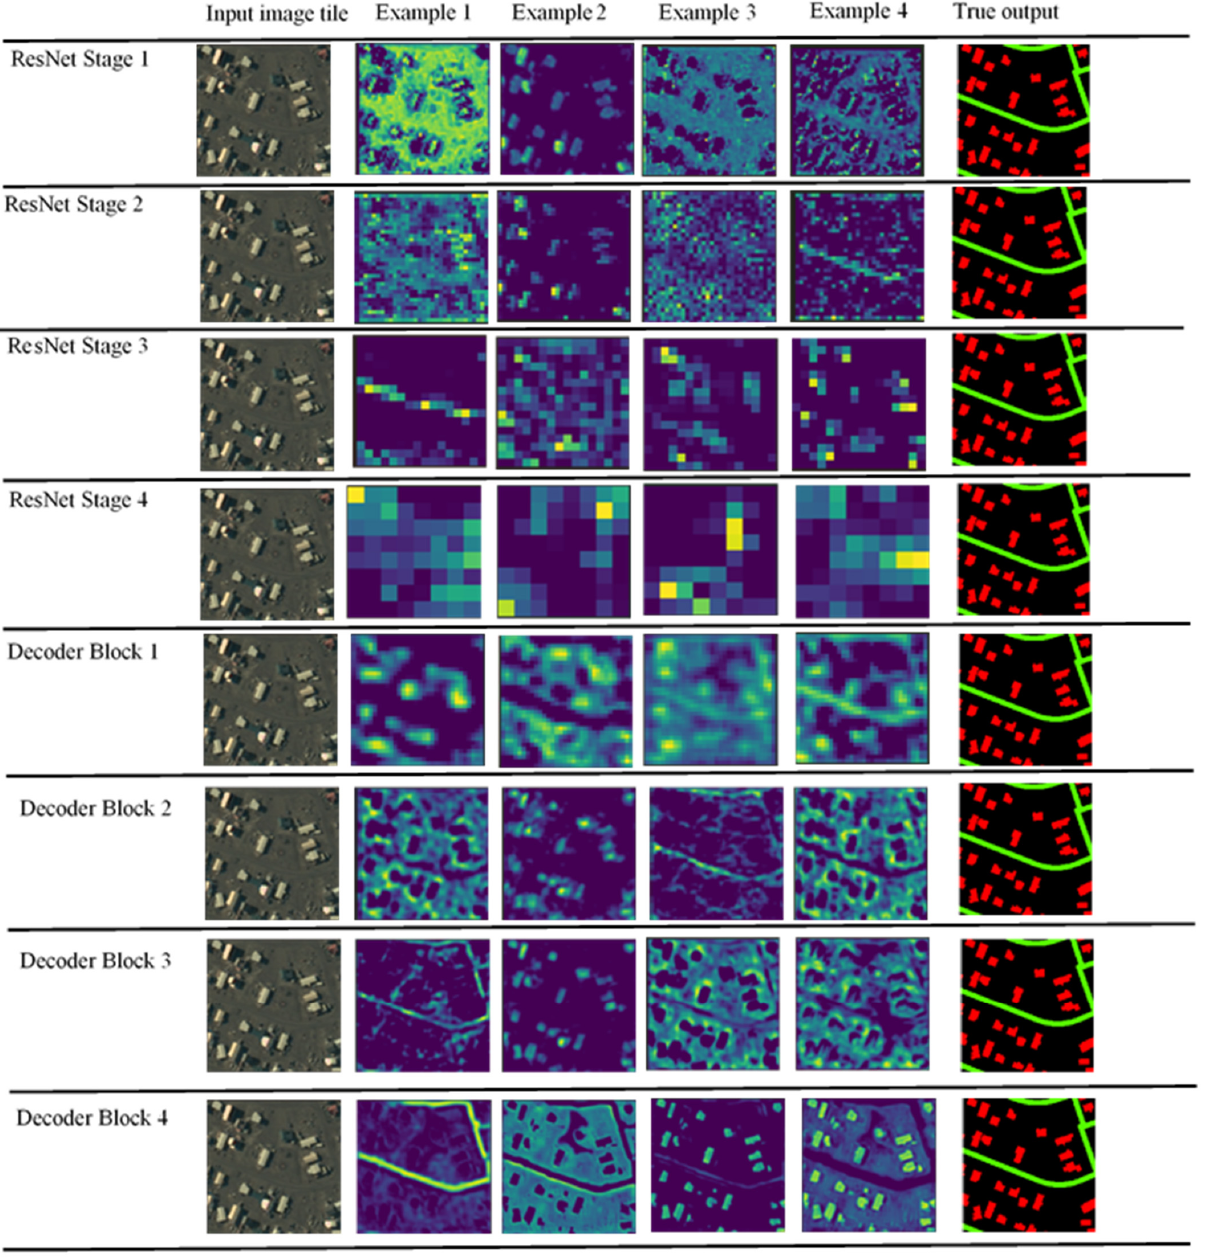
Figure 9. Four selected CFMs (Columns 2–5) from the final layer of each ResNet-50 backbone stage and decoder block. First column contains the input image tile, and final column contains the true output. Each feature map visualizes features learned by the model in detection of residential/commercial buildings and roads. Imagery © DigitalGlobe, Inc.